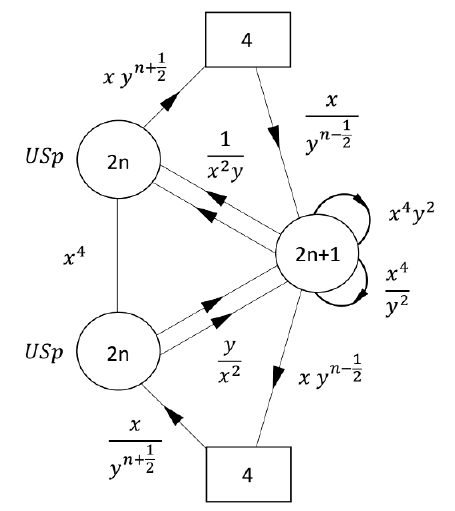
Figure 5 . The proposed 4 d quiver theory. There are cubic superpotentials along all triangles. The label USp is used to denote that these are groups of type USp instead of the usual groups of type SU. As previously, we use arrows from the group to itself to denote antisymmetric chiral (cid:12)elds, where here one is in the antisymmetric representation, and the other in the conjugate antisymmetric representation. These two antisymmetric chirals are coupled to the appropriate bifundamentals via cubic superpotentials. Here x and y are fugacities for the two anomaly free U(1) global symmetry groups, which we denote as U(1) x and U(1) y